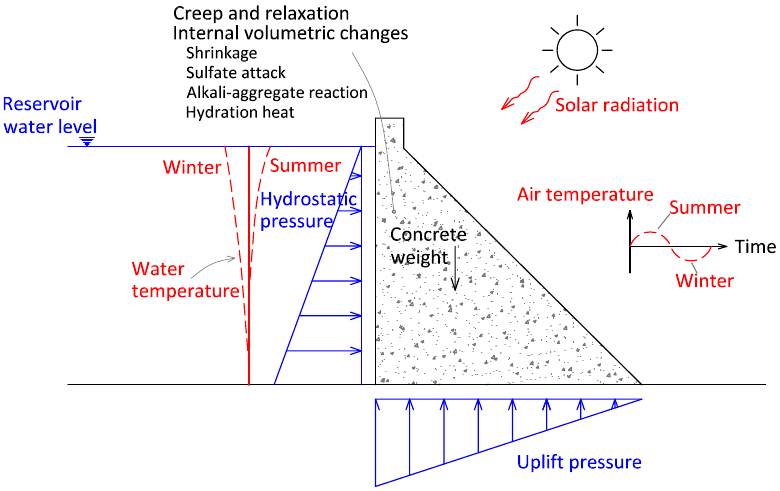
Figure 1. Some parameters analysed for the assessment of dam safety and